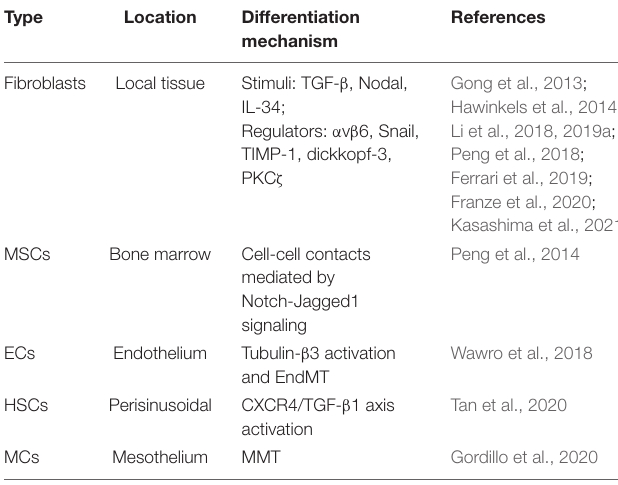
TABLE 1 | The cellular origins of CAFs in